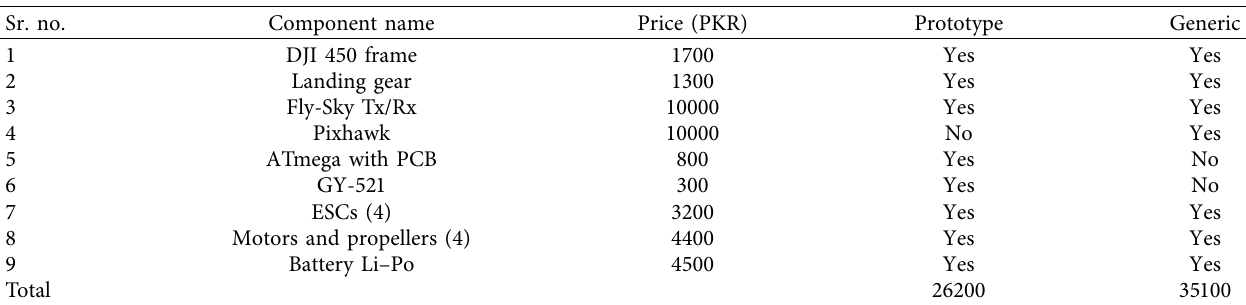
Figure 12: Prototype linear and angular response. Table 8: Cost